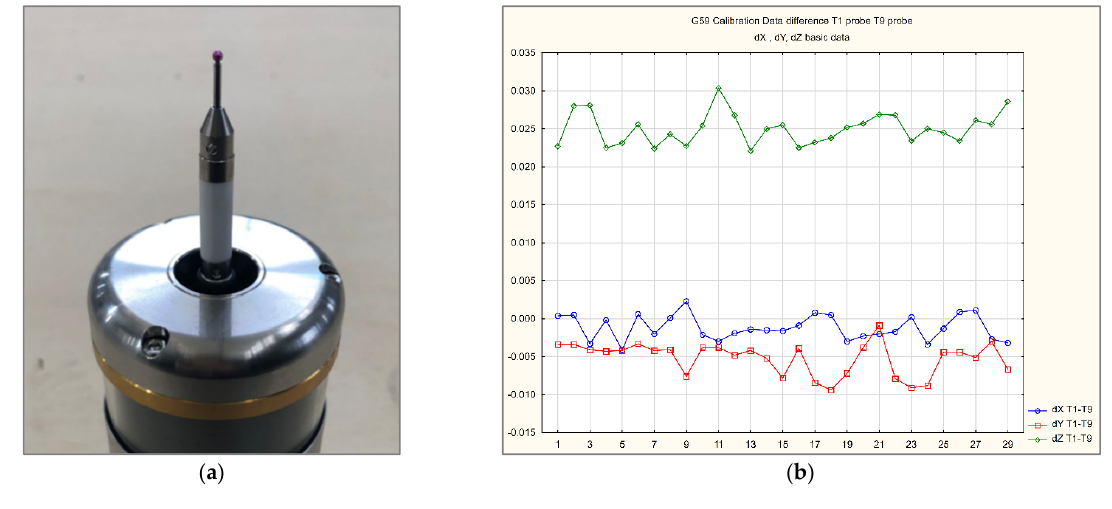
Figure 14. Preliminary stage error investigation features: ( a ) alternative T9 probe shape used for error investigation (preliminary stage); ( b ) run chart of error range between the probes T1 and T9; the XYZ coordinates of calibration working base determined automatically through a dedicated calibration cycle. Table 7. Measurement dispersion for P5 area B 0° head positions for the probes T1, T2, T9, T5, and B 90° head position for T6. Results in [mm].